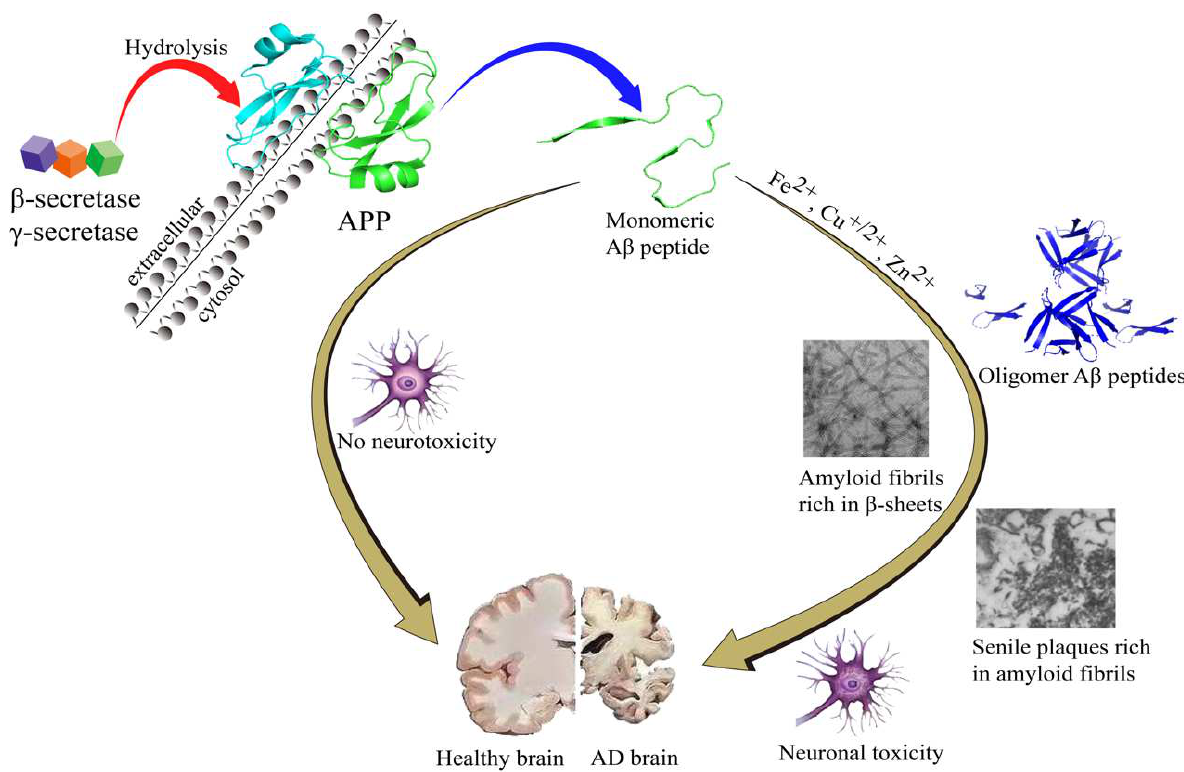
Figure 1. The amyloid cascade hypothesis. Tau protein can stabilize the internal skeleton of nerve cells in the brain. Studies show that the total amount of tau proteins in AD brains is increased significantly, and the in- creased tau proteins are usually in the form of excessive abnormal phosphorylation, which means that if the tau protein is abnormally phosphorylated, it is easy to form paired helical filaments (PHF), which can lead to neurofibrillary tangles (NFTs). NFTs are highly related to the occurrence of AD [22–24]. Clearly, developing new imaging probes that tar- get NFTs is becoming of great significance for the accurate diagnosis of AD.